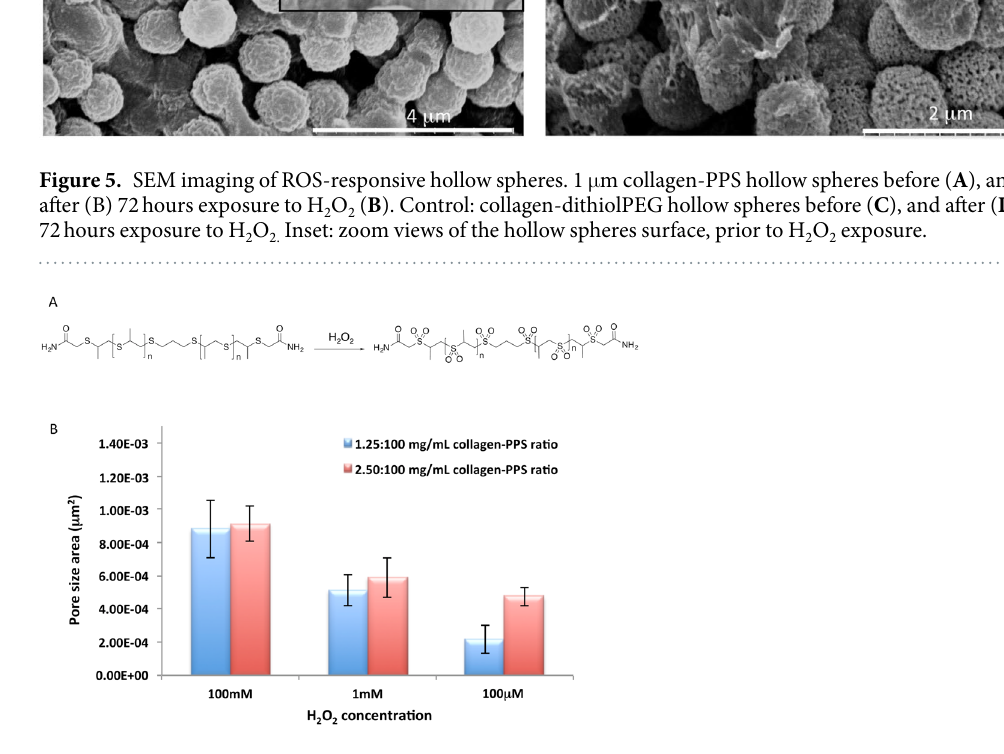
Figure 6. ROS responsiveness quantification. ( A ) Oxidation mechanism of the polypropylene sulfide (PPS) component and ( B ) pore size area distribution of collagen-PPS hollow spheres (evaluated with Image J). All nanoporation analyses were conducted at the 72 hours time